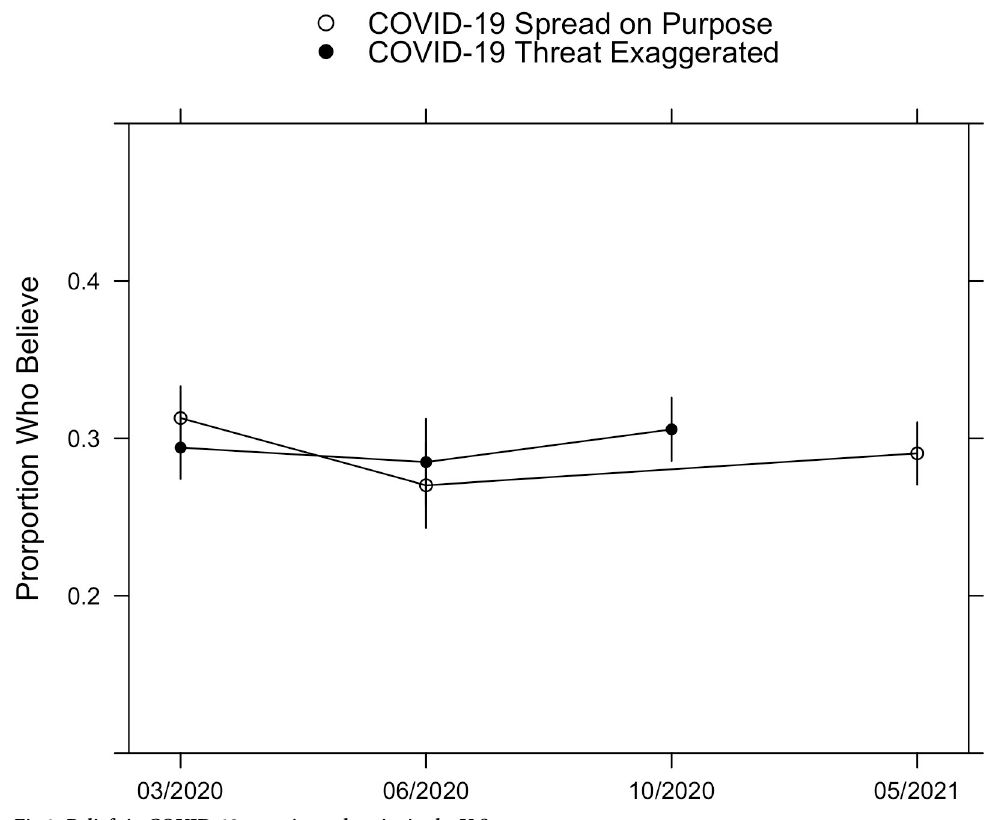
Fig 1. Beliefs in COVID-19 conspiracy theories in the